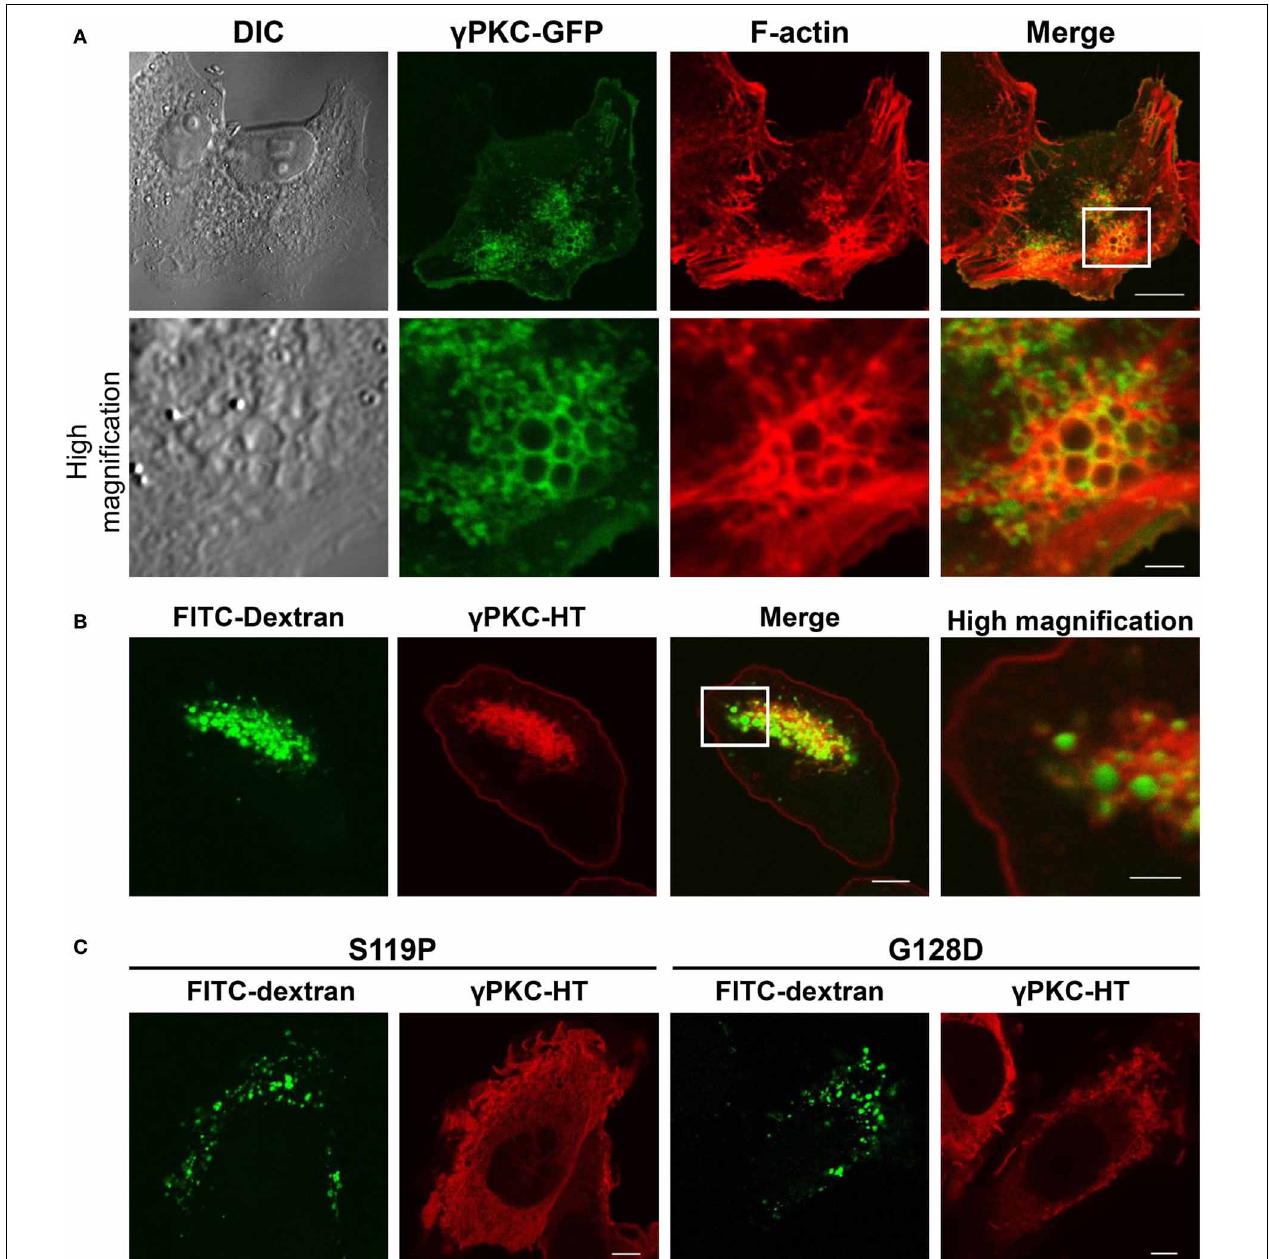
FIGURE 3 | γ PKC, but not SCA14 mutant γ PKC, mediates the TPA-induced remodeling of the actin cytoskeleton and the activation of macropinocytosis. (A) Representative images (DIC, γ PKC-GFP, F-actin, and merged) of γ PKC-GFP-expressing HeLa cells treated with TPA for 30min. The lower panels show high magnification images of the boxed areas in the merged images in the upper panels. F-actin was visualized by staining with 100nM phalloidin-TRITC. Perinuclear γ PKC-GFP was colocalized with F-actin around many large vesicles ( > 0.2 μ m in a diameter). The scale bars in the upper and lower panels are 10 and 2 μ m, respectively. (B) FITC-dextran uptake in γ PKC-HT-expressing cells in response to TPA treatment. FITC-dextran, a fluorescent marker for macropinocytosis, was simultaneously